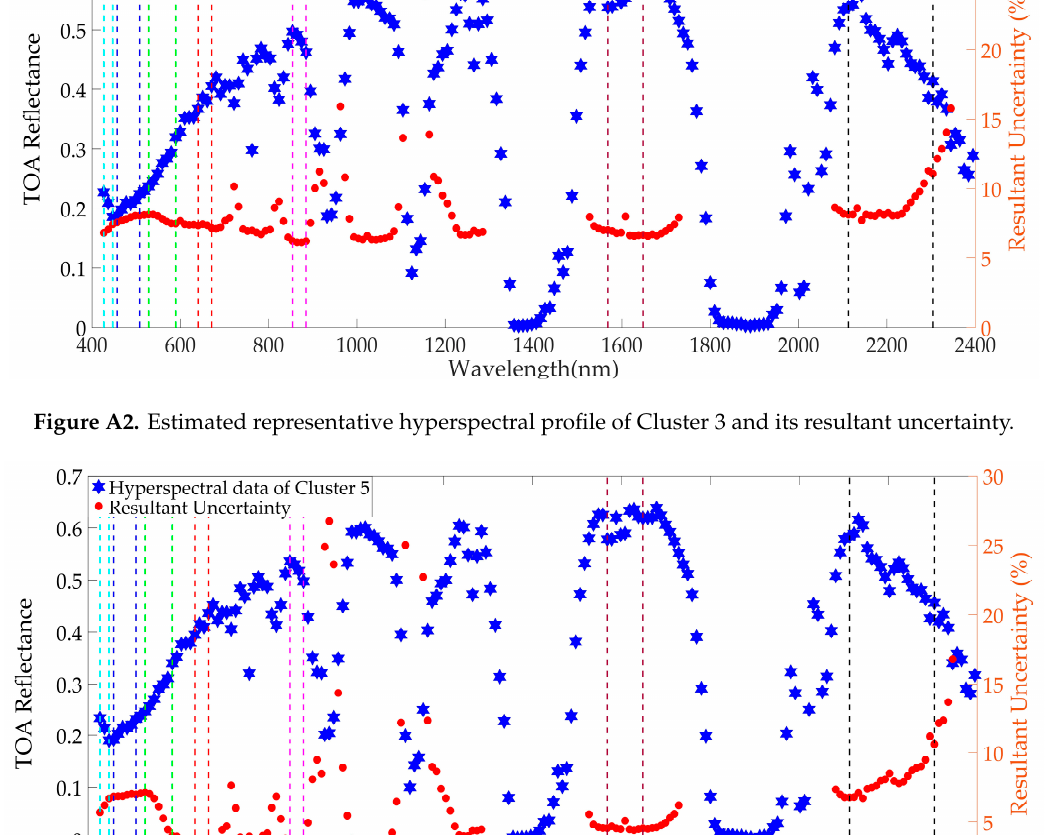
Figure A4. Estimated representative hyperspectral profile of Cluster 6 and its resultant uncertainty.